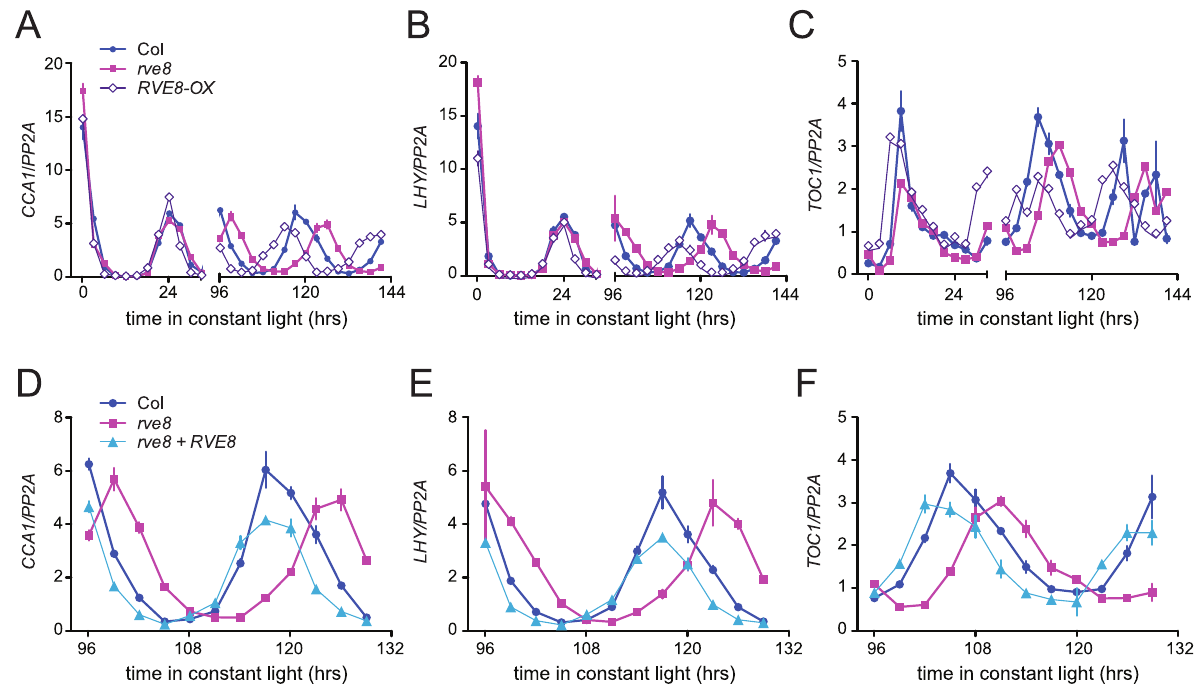
Figure 6. Expression of CCA1 , LHY , and TOC1 in rve8 and RVE8-OX . Seedlings were entrained 12 hr light:12 hr dark for 6 days before being transferred to continuous white light and harvested at the indicated times. Expression of CCA1 (A, D), LHY (B, E), and TOC1 (C, F) was determined using qRT-PCR in (A–C) Col, rve8-1 , RVE8-OX , and in (D–F) Col, rve8-1 , and rve8-1 plants transformed with the RVE8 genomic region. Values are expressed relative to PP2a . Error bars represent 6 SE. These data are representative of at least two independent experiments.